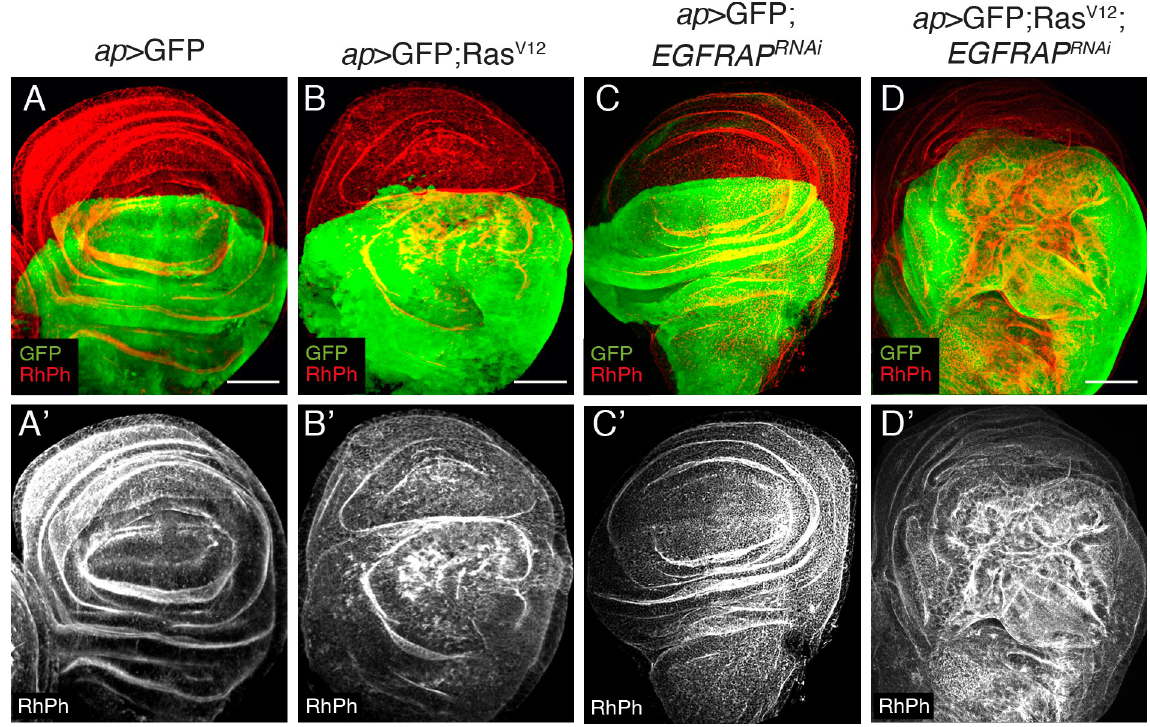
Fig 1. EGFRAP Knock down enhances Ras V12 -dependent tissue hyperplasia in Drosophila wing imaginal discs. (A-D) Maximal projection of confocal views of wing imaginal discs from third-instar larvae expressing GFP (green) and the indicated UAS transgenes under the control of apterous Gal4 ( ap-Gal4 ), stained with anti-GFP (green) and Rhodamine Phalloidin to detect F-actin (RhPh, red) (A’-D’). Scale bars, 50 μ m (A-D).